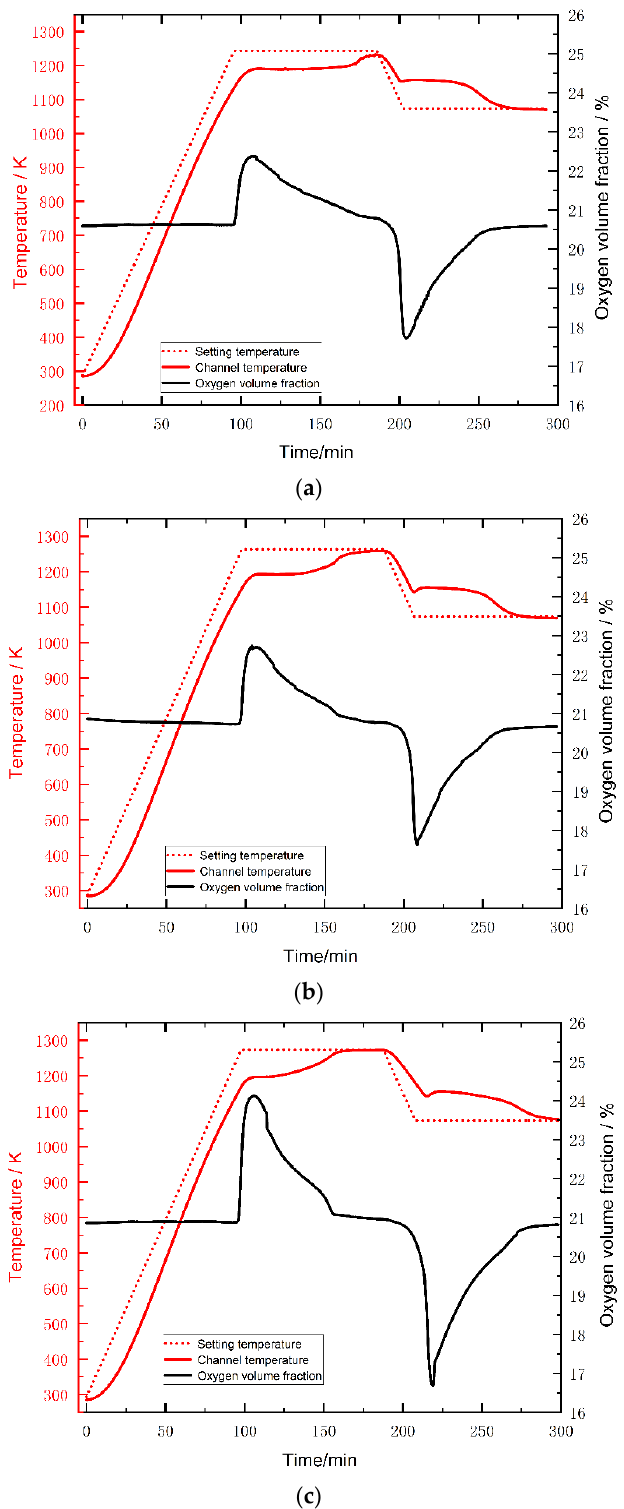
Figure 4. Charging/discharging characteristics of cobalt-oxide honeycomb structure at different temperature windows. ( a ) 970–800 ◦ C temperature window; ( b ) 990–800 ◦ C temperature window; ( c ) 1000–800 ◦ C temperature